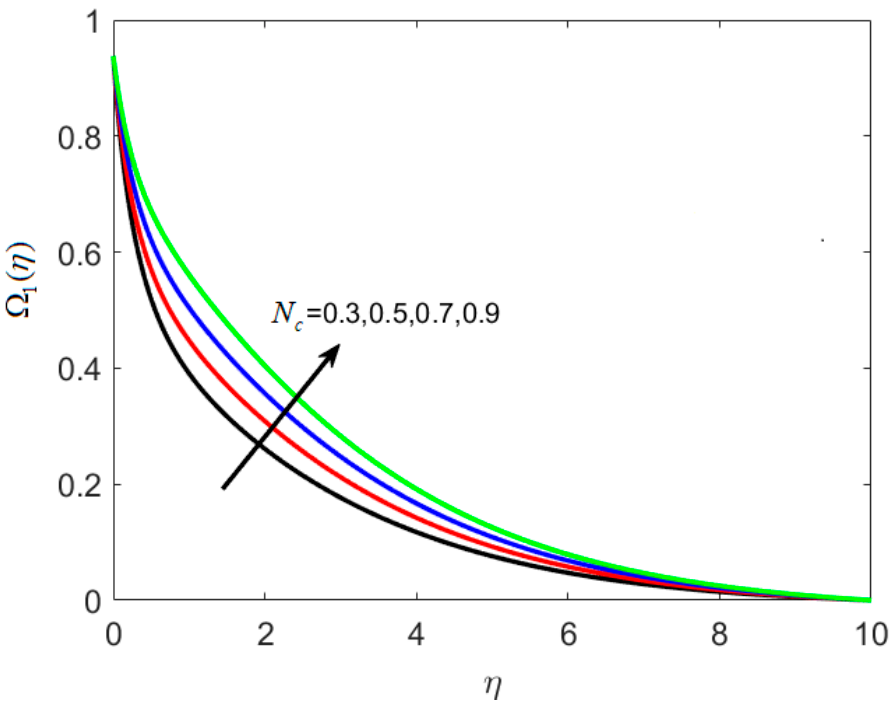
Figure 7. Various estimates of dimensionless concentration ratio parameter N c by taking B 1 = 1.3, B 2 = 1.2, S t = 0.3, λ h = 0.1, N t = 0.3, γ = 0.2, κ ∗ = 0.1, Le = 0.2, δ = 0.3.